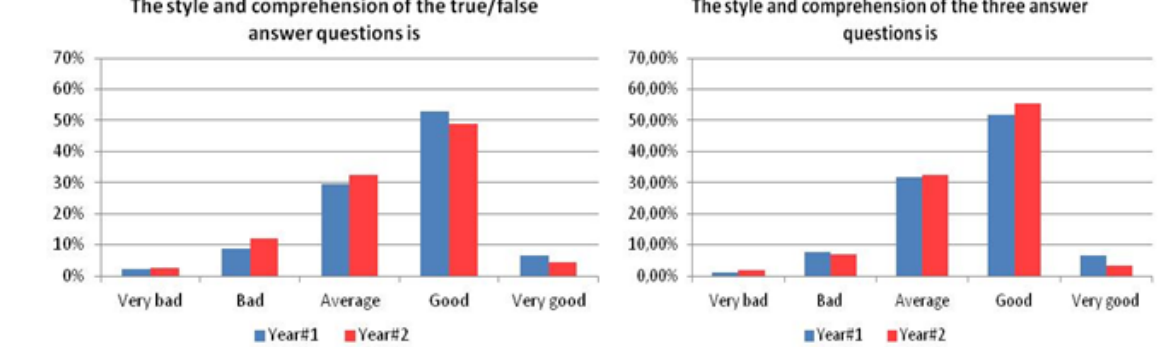
Figure 7. Style and comprehension of the